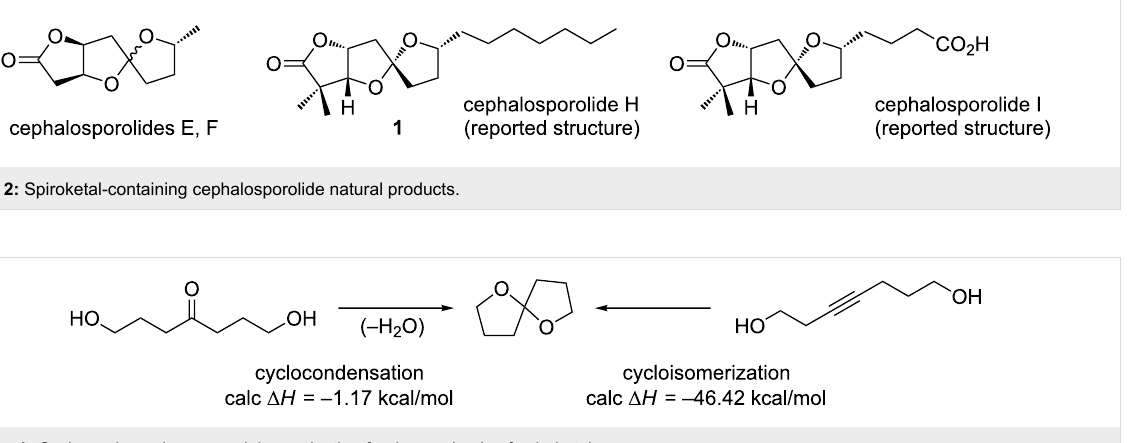
Scheme 1: Cyclocondensation vs. cycloisomerization for the synthesis of spiroketals.